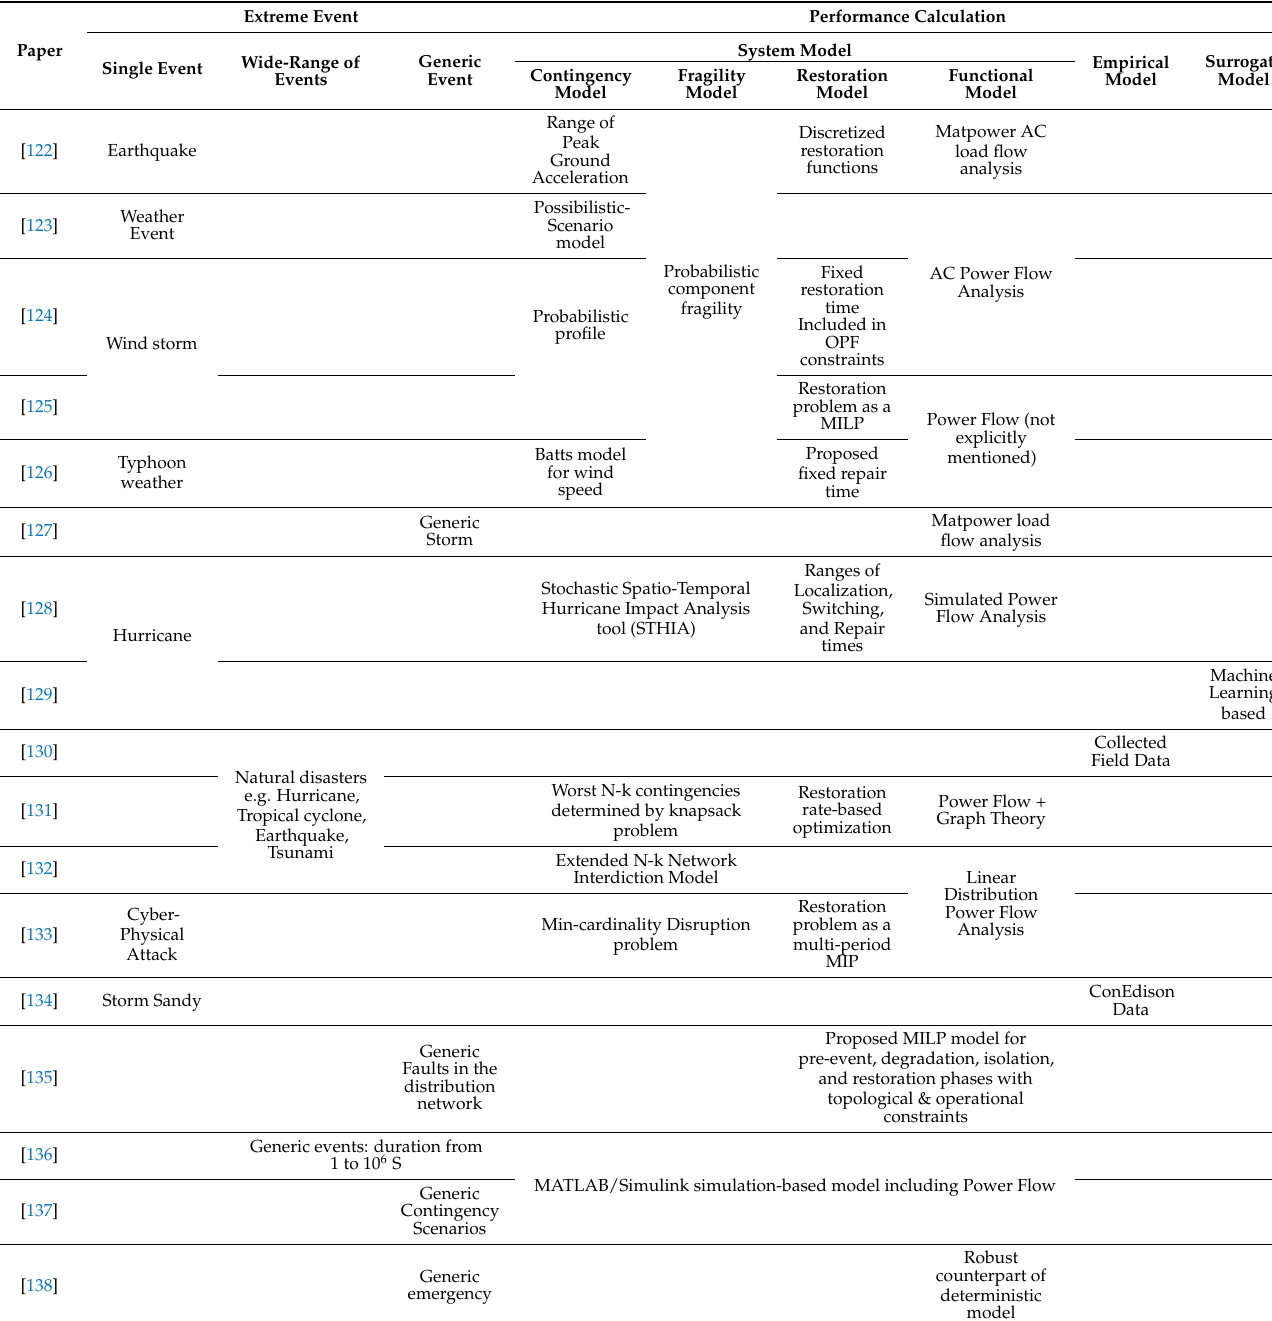
Table 1. Review of handled extreme event and performance calculation method—electric